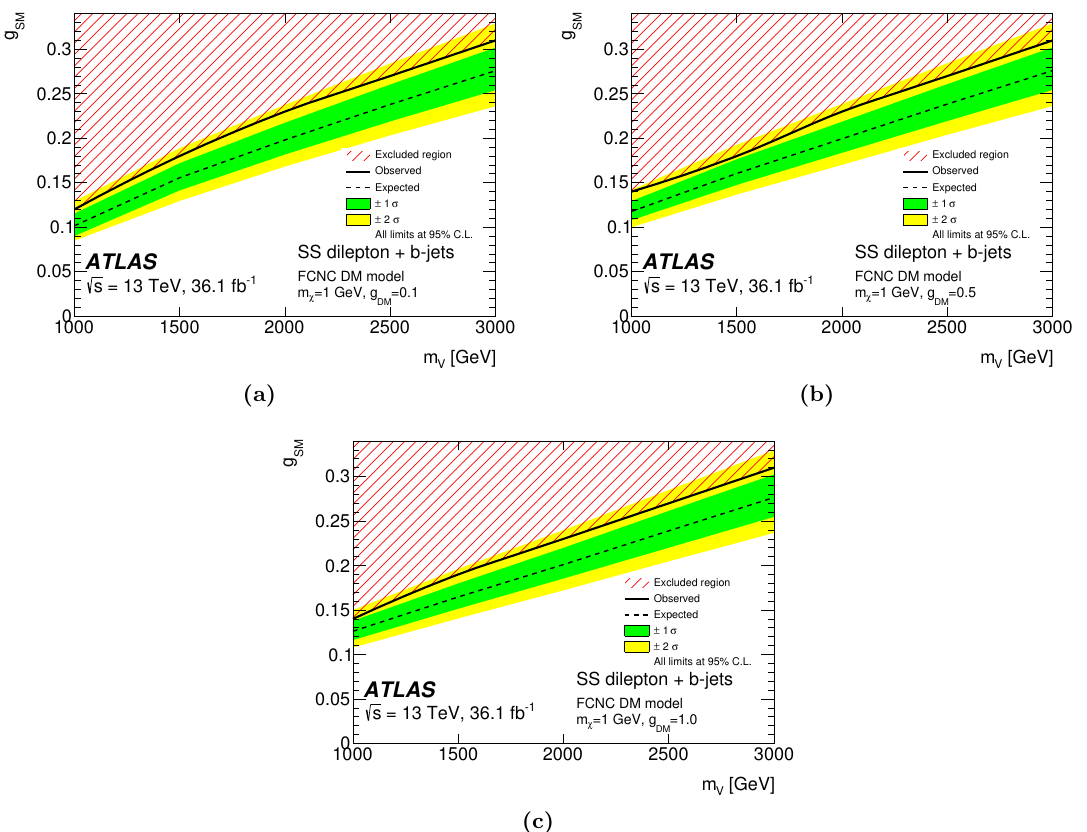
Figure 14 . Expected and observed constraints in the ( g SM ; m V ) plane for the combined visible same-sign top-quark pair production, (a) g DM = 0 : 1, (b) g DM = 0 : 5, (c) g DM = 1. In all plots, the expected 95% CL limits are shown with their 1 and 2 standard deviation bands. The mediator (cid:6) (cid:6) width e(cid:11)ects are taken into account for every value of the model